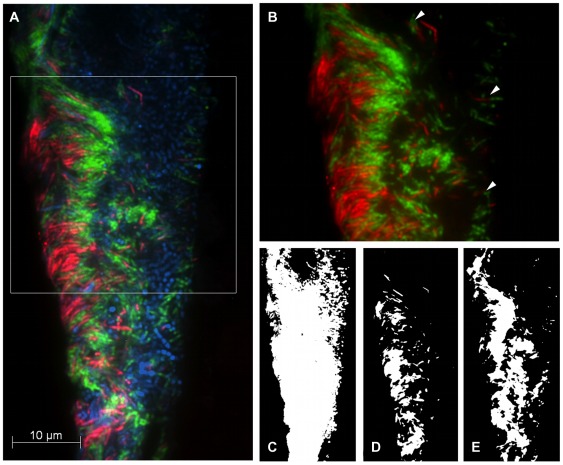
Representative micrograph of spatial interaction between T. forsythia and F. nucleatum/periodonticum.FISH was performed on sections of 7-day-old subgingival biofilm grown on e-PTFE carriers in gingival pockets of GAP patient 01. T. forsythia and F. nucleatum/periodonticum were fluorescently labeled with the species-specific probes TAFO-Cy3 (red) and FUNU-Cy5 (green), respectively. The spatial expansion of the entire biofilm was revealed with the domain-specific probe EUB338-FITC (blue). (A) The overlay of the Cy3, Cy5 and FITC channels shows the periodontal plaque between the gingival surface at the right edge and the carrier surface on the left. F. nucleatum/periodonticum (green) is densely packed together with T. forsythia (red) and appear to co-localize within an amorphous interwoven cluster focused on the carrier adjacent side. (B) Species-specific channels Cy3 and Cy5 in higher magnification. Single cells of T. forsythia, dispersed in the middle and right part of the biofilm, were found in close contact to F. nucleatum/periodonticum cells (arrowheads). (C–E) shows the respective binary masks of the micrograph (A) prepared for spatial arrangement analysis provided by the software daime. (C) The EUB338-FITC-channel served as reference mask to limit the calculation to the area of the biomass. (D–E) Between the segmented masks of species-specific channels TAFO-Cy3 (D) and FUNU-Cy5 (E) daime calculated the pair cross correlation function g(r).